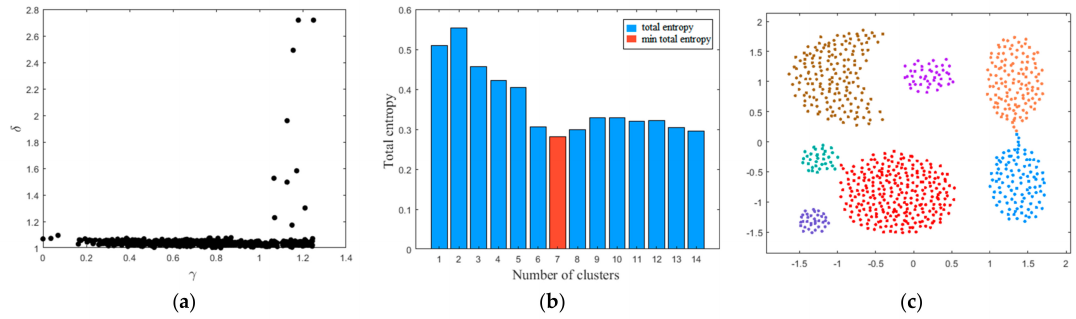
Figure 2. MDPC on the Aggregation dataset: ( a ) γ − δ decision graph; ( b ) total entropy with different number of clusters; ( c ) visual clustering result.